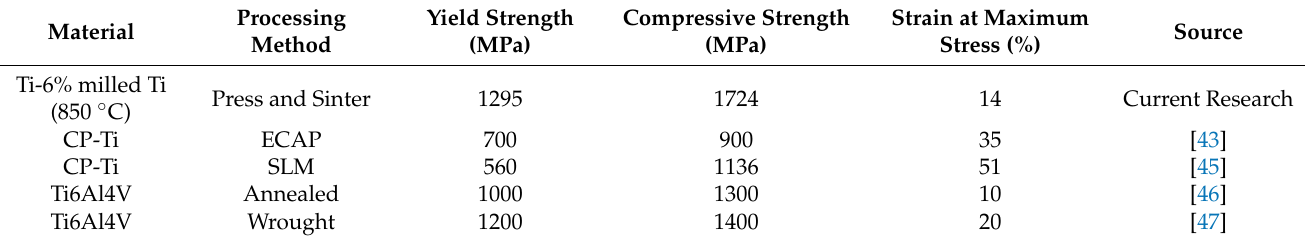
Table 4. Mechanical properties of titanium alloys fabricated by various processing technologies.